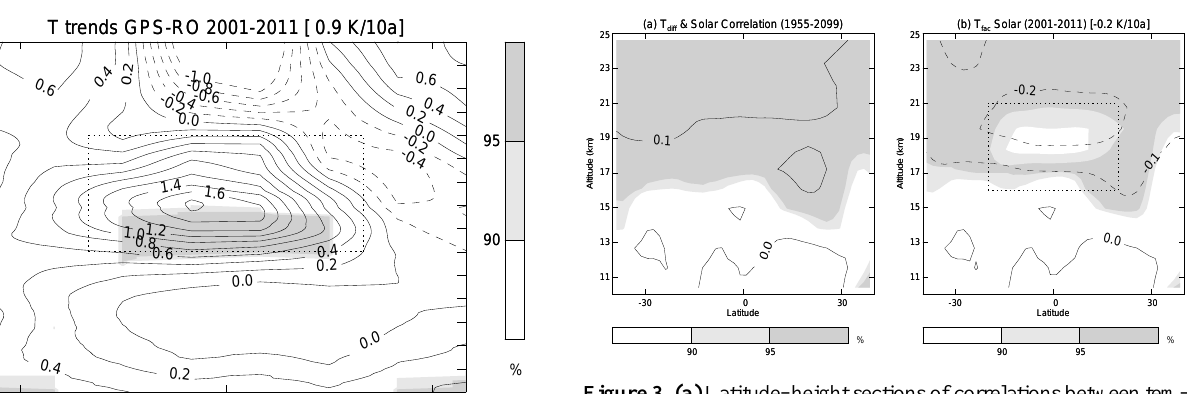
Figure 3. (a) Latitude–height sections of correlations between tem- perature differences (Natural – SolarMean) and solar TSI in the Natural run over the whole period (1955–2099); contour interval is 0.1; grey shading represents statistically significant correlations, with Student’s t test. (b) The regressed contributions of solar TSI to the TTL temperature trends during 2001–2011 (Eq. 2); contour interval is 0.1Kdecade − 1 ; grey shading represents statistically sig- nificant regressions. See text for details on the calculation of the regressed trend and the testing of the statistical significance. The decadal temperature trend in the title is the mean value from the dashed box.